Question: Summarize what this figure shows in one sentence.
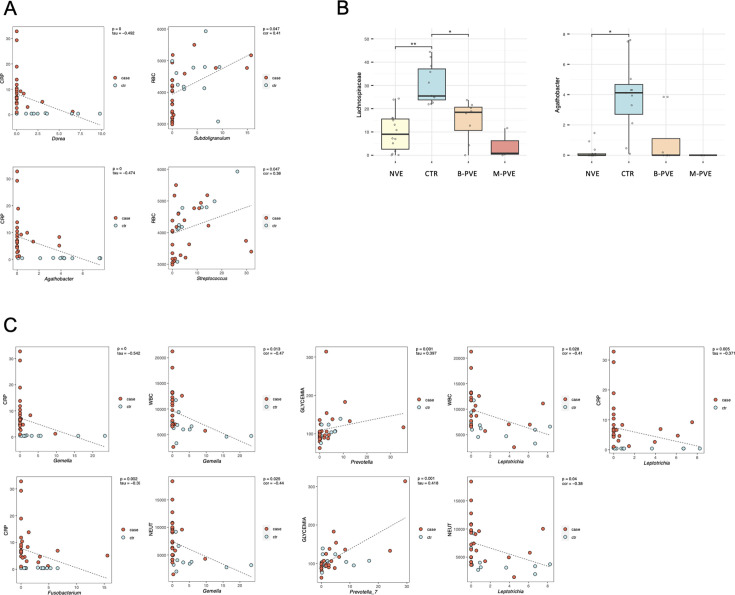
Answer: Associations between microbial genera and host clinical features . ( A ) Scatter plots showing correlations between gut microbiota genera and host metadata for cases and controls. ( B ) Boxplots showing the relative abundance of gut taxa differentially represented between cases and controls stratified by valve type (NVE: cases with native valve; CTR: controls with native valve; B-PVE: cases with bioprosthetic valve; M-PVE: cases with mechanical valve). Wilcoxon test, * P ≤ 0.05; ** P ≤ 0.01. ( C ) Scatter plots showing correlations between oral microbiota genera and host metadata for cases and controls. Only statistically significant correlations ( P ≤ 0.05) with absolute Kendall’s tau ≥ 0.3 for genera with relative abundance ≥1% are shown.